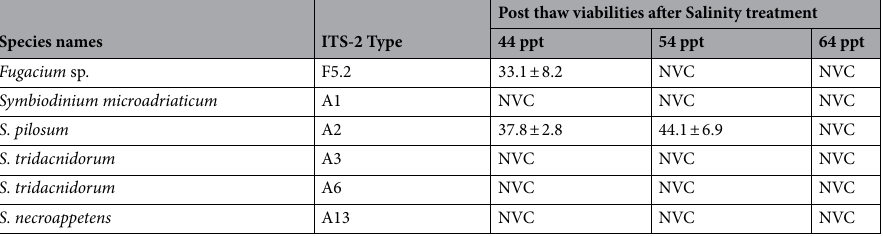
When the selected Symbiodiniaceae culture isolates were grown in f/2 media set at 64 ppt salinity, none of the treated strains survived (Table 5).